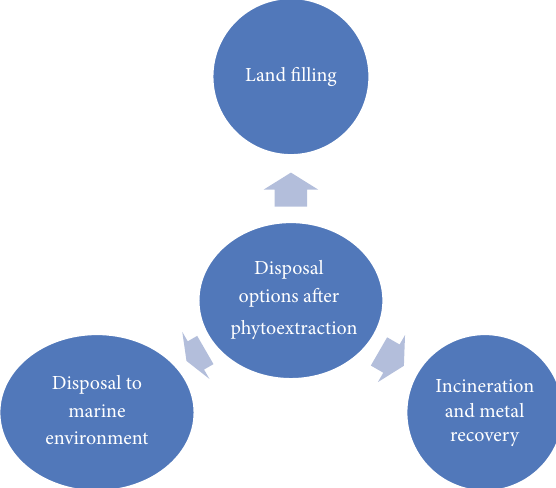
Figure 2: Various options for arsenic containing wastes